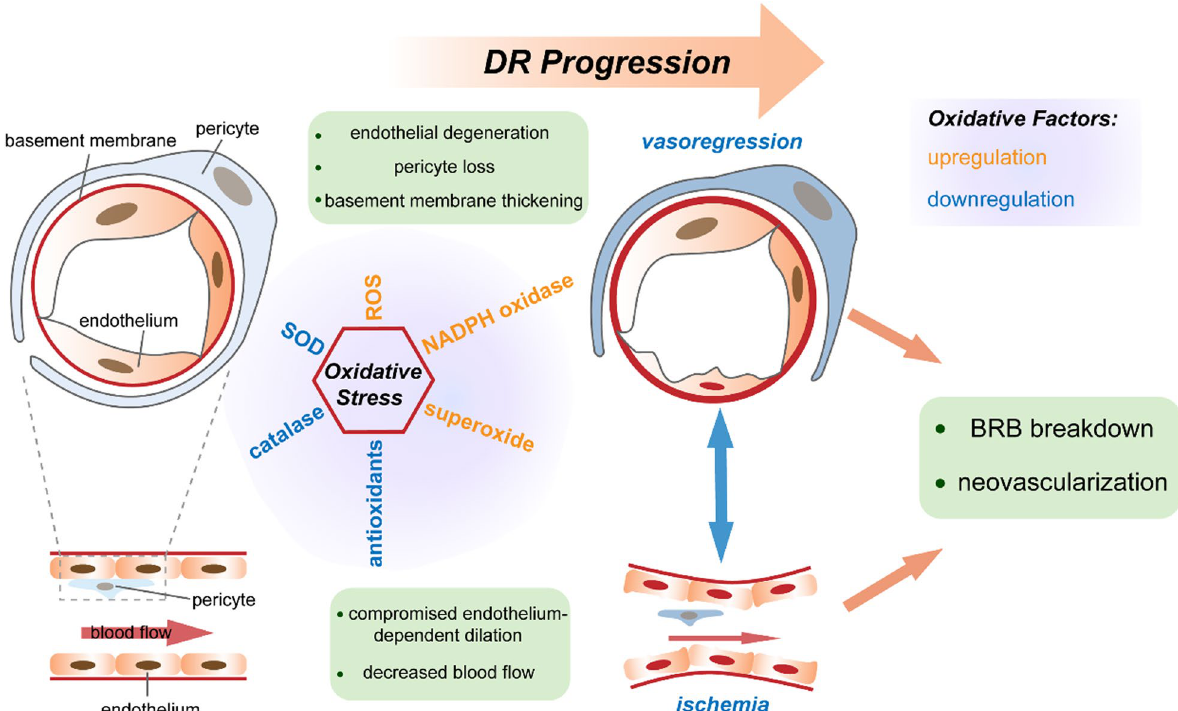
Fig. 1 Schematic illustration of retinal vascular aging in response to oxidative stress in diabetic retinopathy (DR). Oxidative stress is manifested as increased levels of ROS, NADPH oxidase and superoxide, in contrast with decreased expression of SOD, catalase and antioxidants. Oxidative stress induces endothelial degeneration, pericyte loss and basement membrane thickening, which aggravates vasoregression in the process of DR. Concurrently, retinal ischemia occurred due to the compromised endothelium-dependent dilation and decreased blood flow in retinal microvessels. Vasoregression and ischemia coordinate with each other and eventually result in BRB breakdown and neovascularization during DR progression. ROS: reactive oxygen species, SOD: superoxide